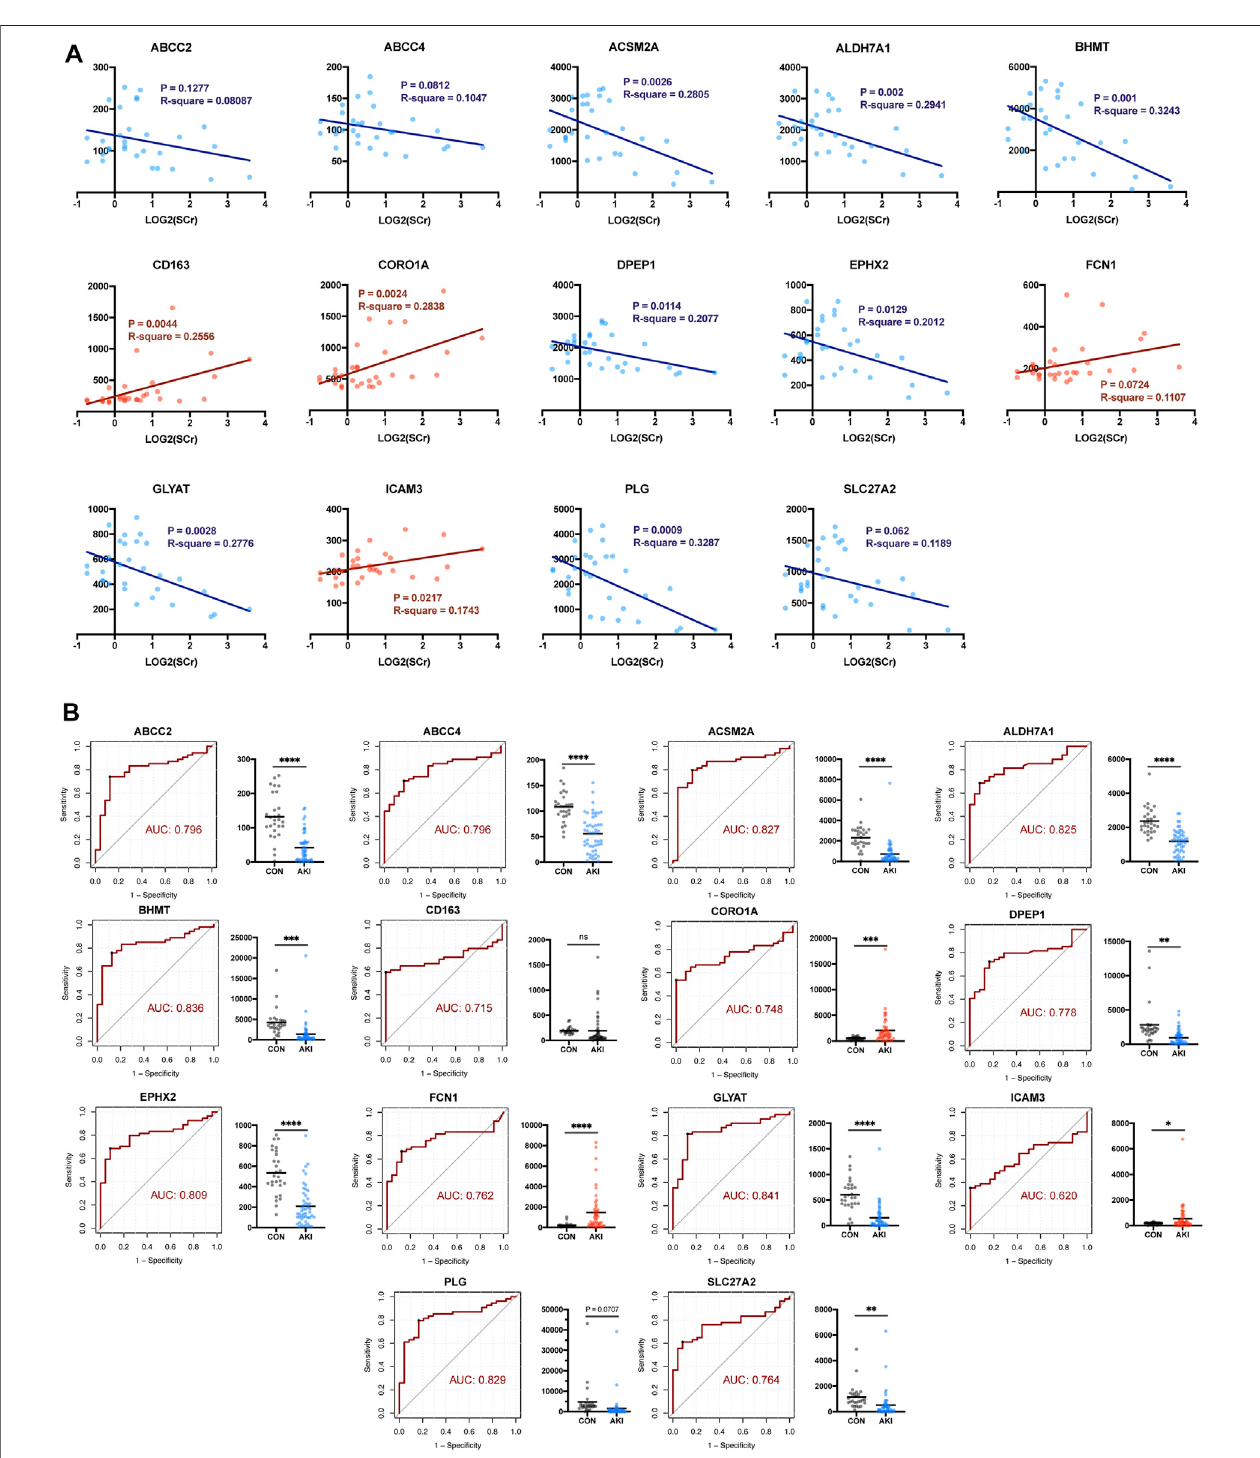
FIGURE 6 | Self-validation of RFRGs by regression analysis based on GSE1563 and GSE139061. (A) Regression analysis between the value of log 2 (SCr) and transcriptional level of RFRGs. (B) ROC curve and AUC value are calculated, and expression levels between the control and AKI group are shown in the histogram plot. * p < 0.05, ** p < 0.01, *** p < 0.001, and **** p < 0.0001 vs. the control group.